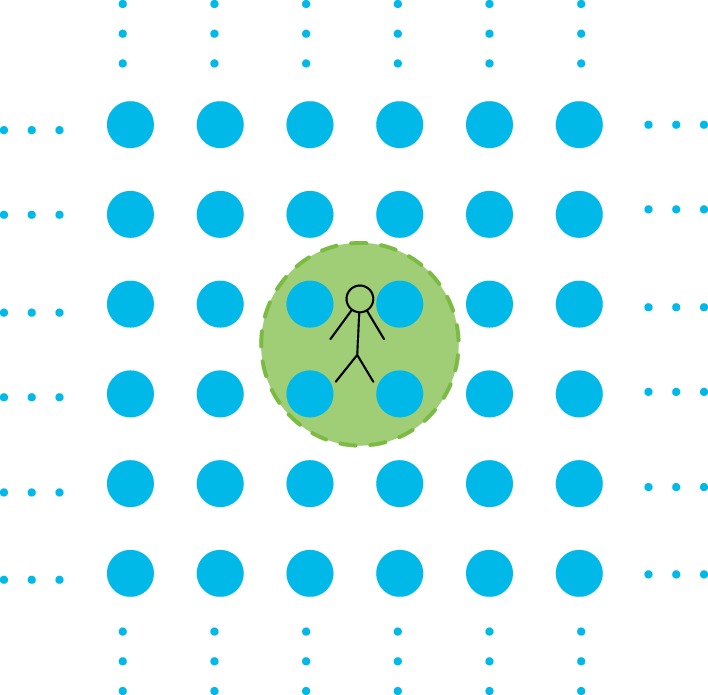
An agent exploring his surroundings in an infinite TI lattice. In the picture, the agent only has access to the random variables corresponding to four nearby sites. How are the statistics of the corresponding four random variables restricted by the TI condition? (Online version in colour.)